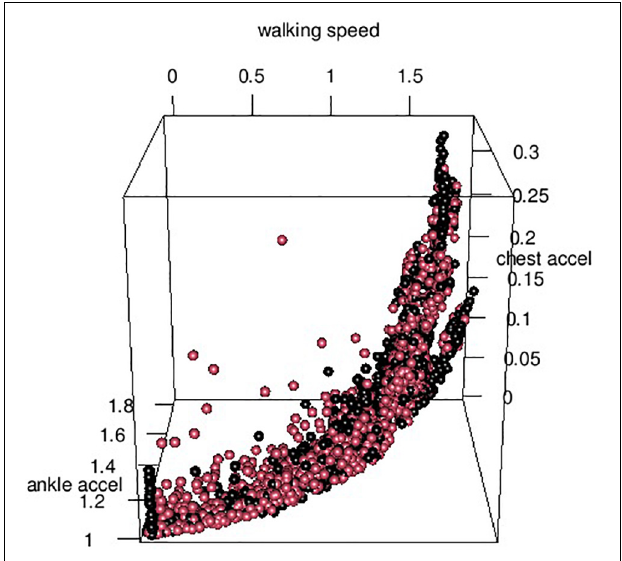
FIGURE 4 | Distribution of orientation status across features. Three-dimensional representation of the distribution of orientation status (oriented – black beads, disoriented – red beads) across ankle and chest-worn accelerometric signal and walking speed